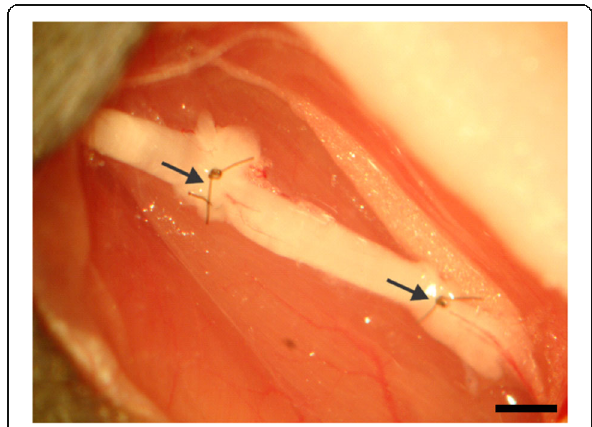
Fig. 1 Autografting procedure in which 5 mm of the sciatic nerve of a mouse is transected, rotated 180 degrees, and then is sutured or stitched together by nylon suture and fibrin sealant (20×